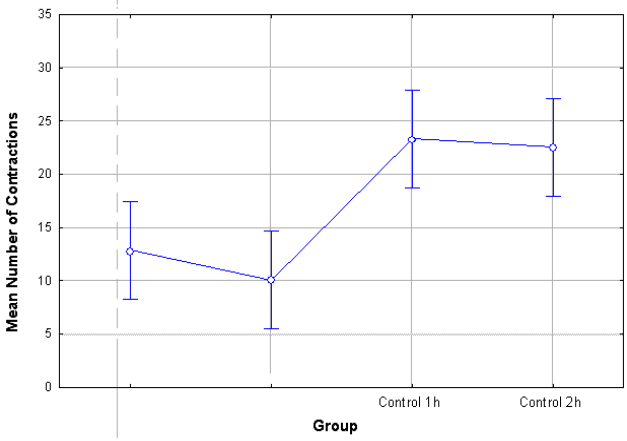
FIGURE 2 - The mean number of contractions at 1 and 2 h in the groups studied